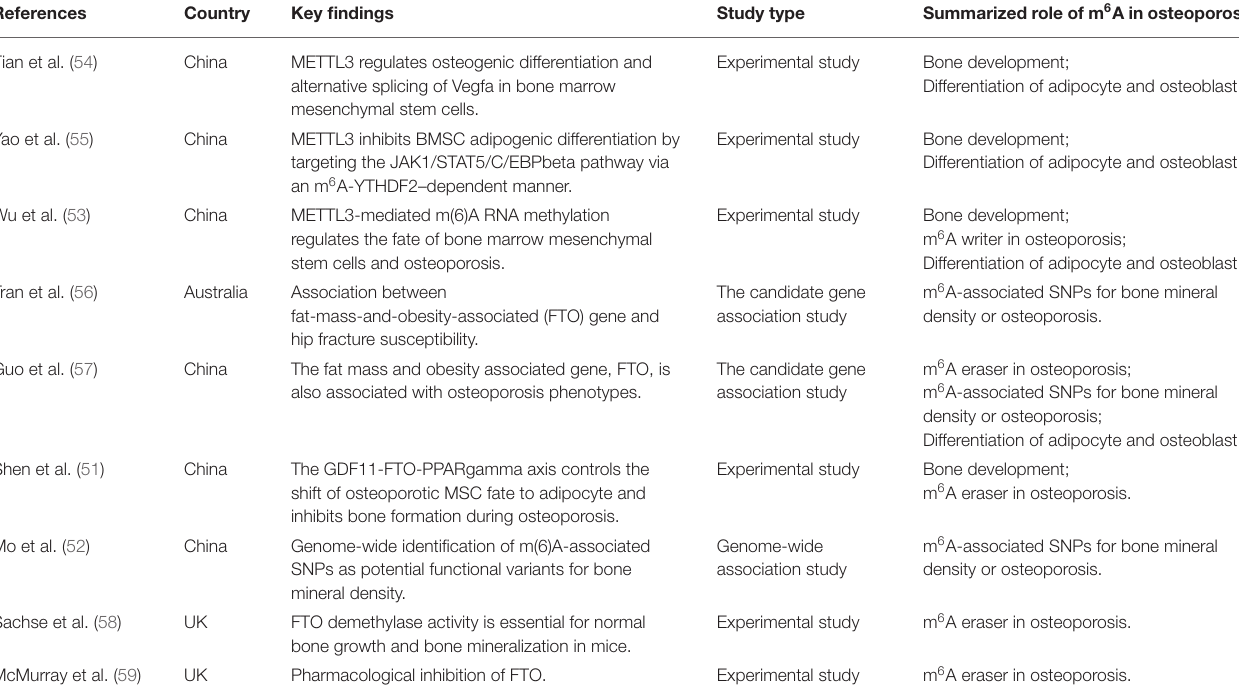
TABLE 1 | Summary of included studies about the regulatory role of m 6 A mRNA modification in